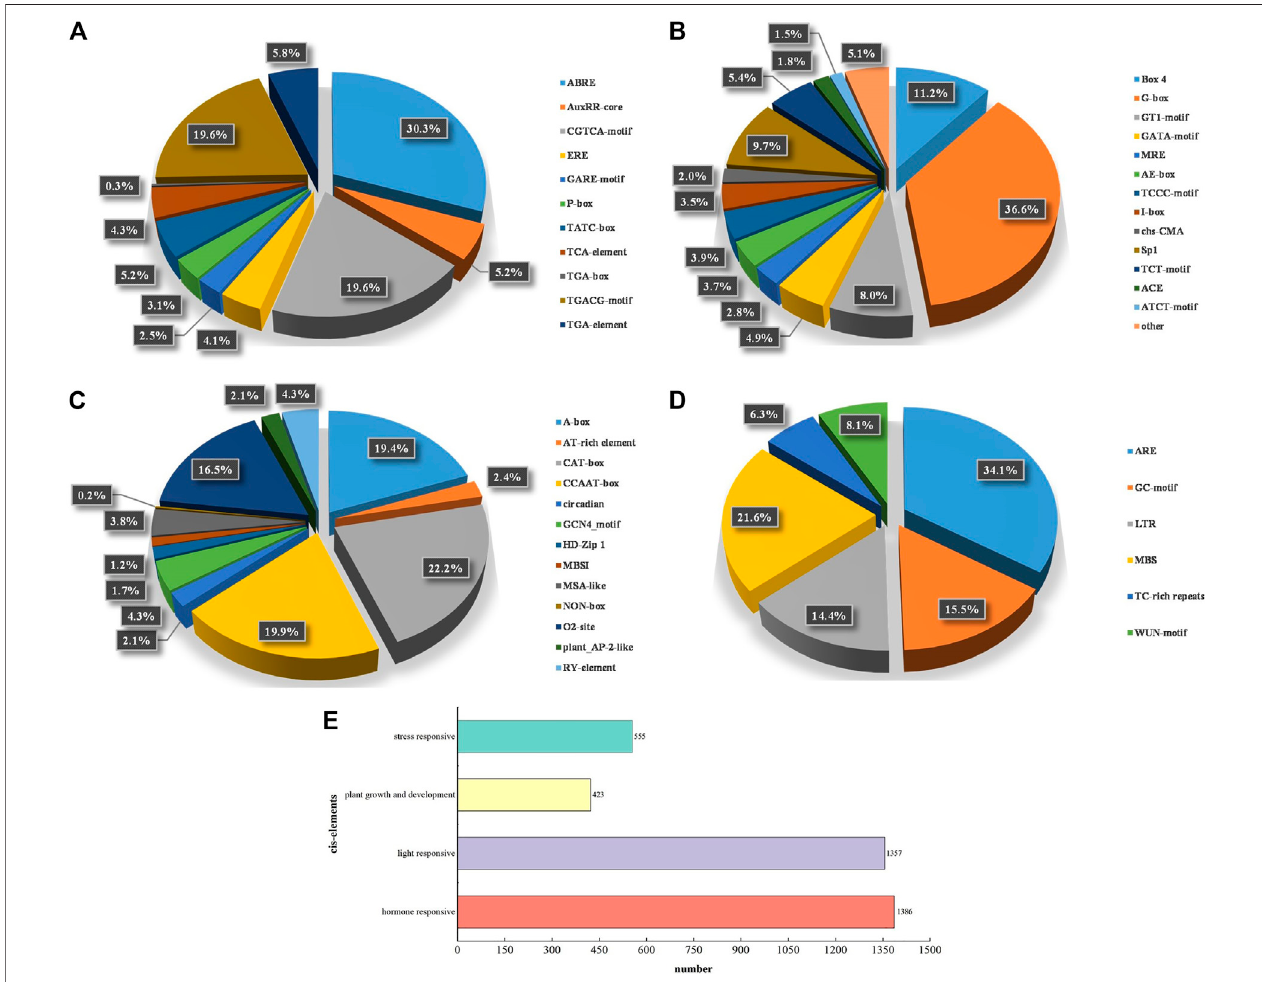
FIGURE 3 | The analyses of cis-acting elements found in PePUB genes. (A) hormone-responsive, (B) light-responsive, (C) plant growth and development, (D) stress-responsive. (E) The sum of cis-elements in the four categories. Different colors indicate different cis-acting elements and the ratio of cis-elements present in PePUB